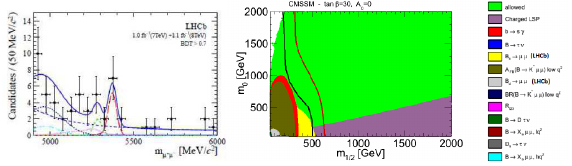
Figure 6: LHCb signal for B 0 presently CMSSM allowed region (green) on the plane ( m 0 , m ) [55] 1 / 2